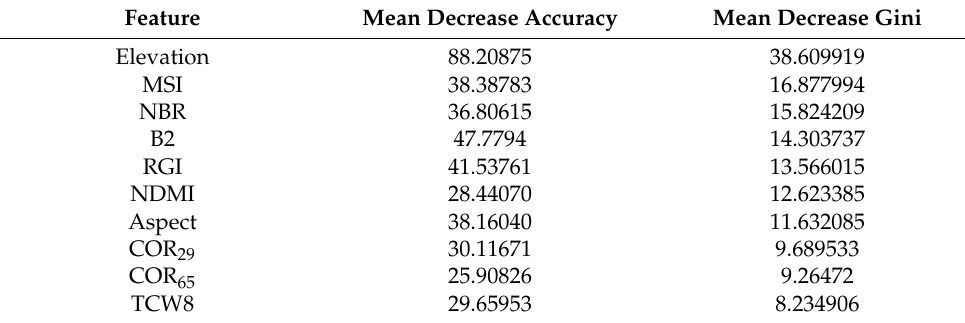
Table 3. Ranking results of Gini importance